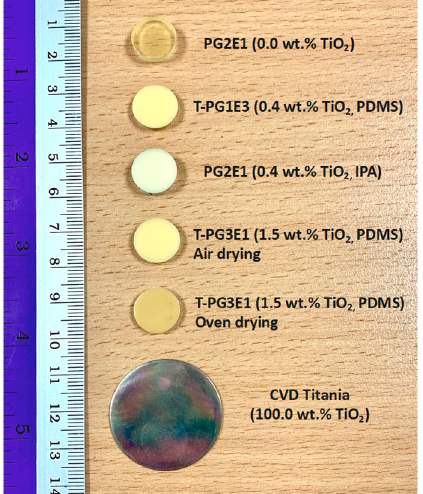
Figure 2. Photographs of Titania–polyurea spray coating samples.